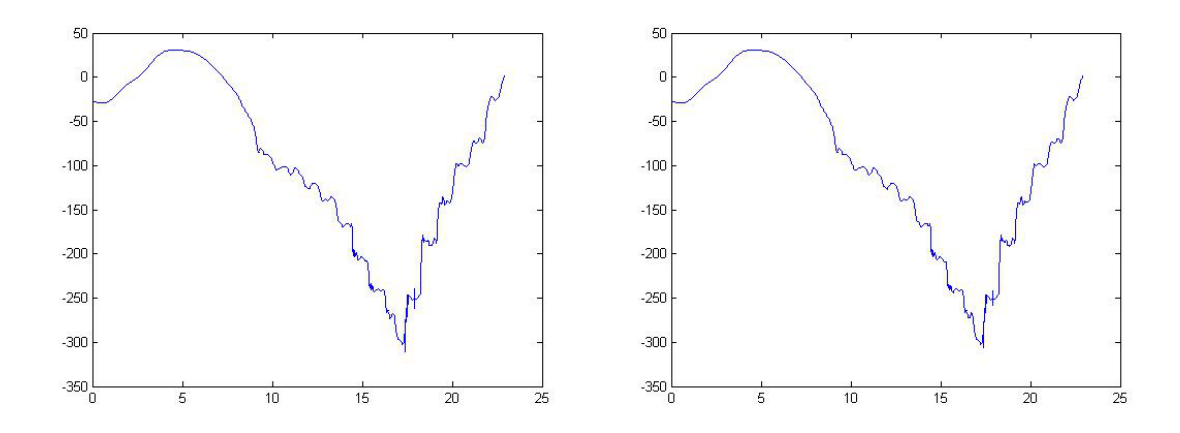
Figure 5: De-noised Results of the differential pressure signal.